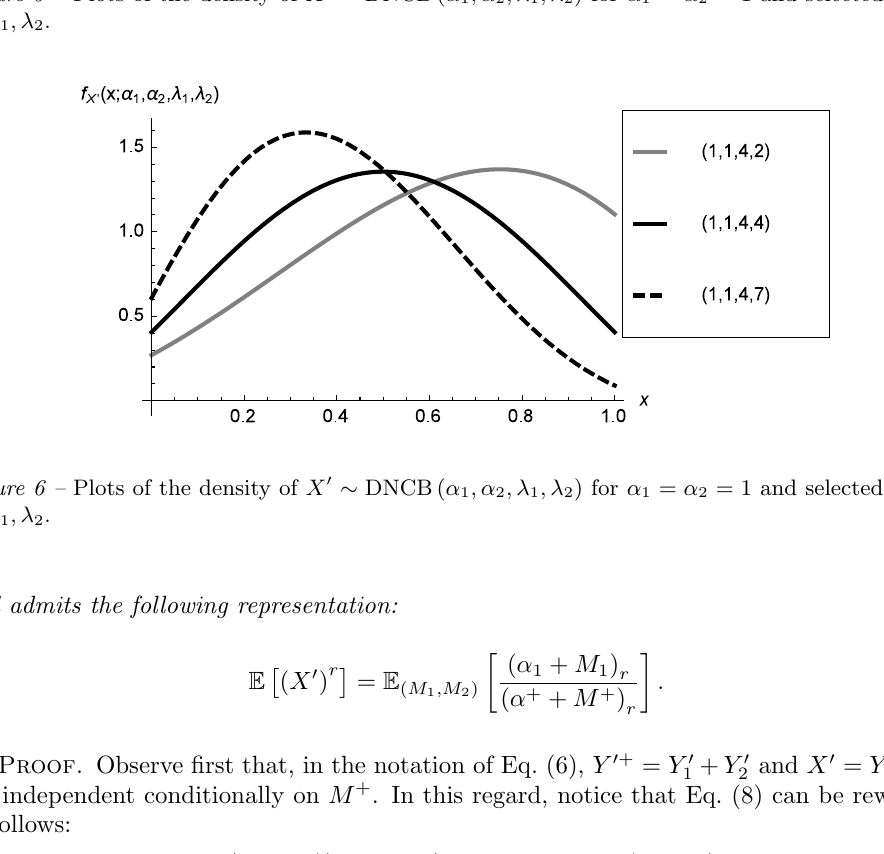
Figure 5 { Plots of the density of X ′ (cid:24) DNCB ( (cid:11) 1 ; (cid:11) 2 ; (cid:21) 1 ; (cid:21) 2 ) for (cid:11) 1 = (cid:11) 2 = 1 and selected values of (cid:21) 1 ; (cid:21) 2 .